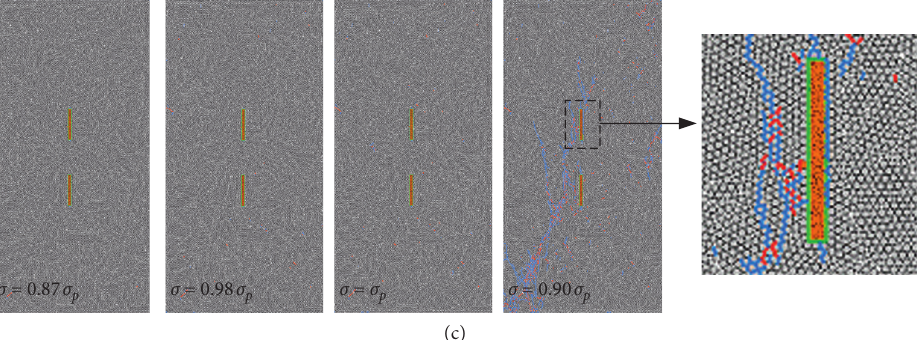
Figure 8: Crack development process of samples containing infilled flaws with the same β of 90 ° and different α of 0 ° , 45 ° , and 90 ° (blue lines represent tensile cracks and red lines represent shear cracks). (a) α � 0 ° and β � 90 ° , (b) α � 45 ° and β � 90 ° , (c) α � 90 ° and β � 90 °